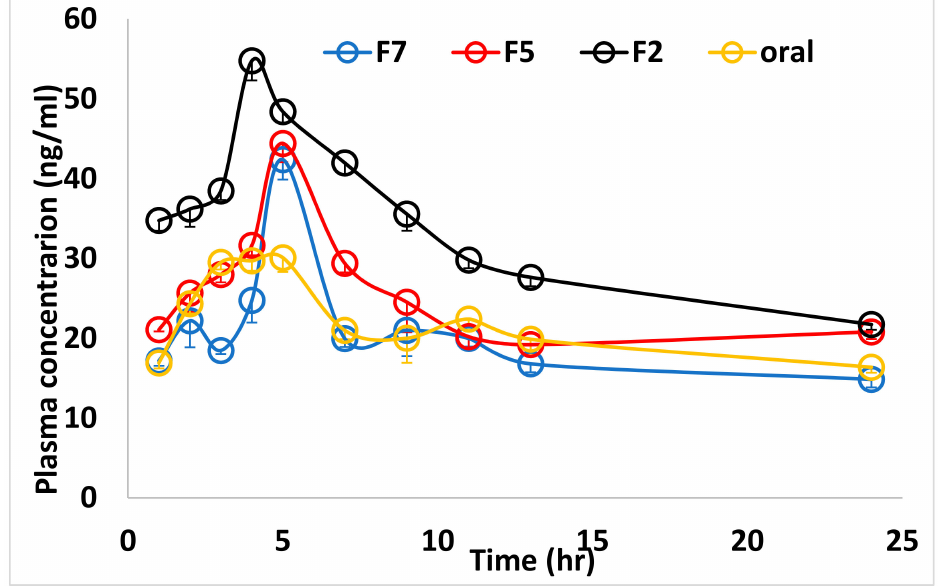
Figure 6. Means of plasma concentrations of Candesartan at different time points among